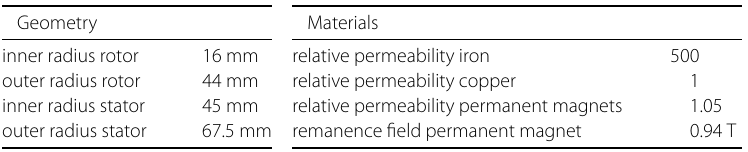
Table 1 Geometry and material parameters of the machine Geometry